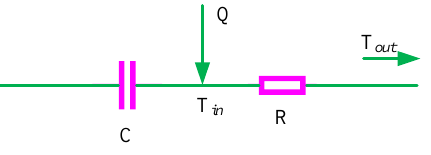
Figure 1. First-order equivalent thermal parameter model of air-conditioning